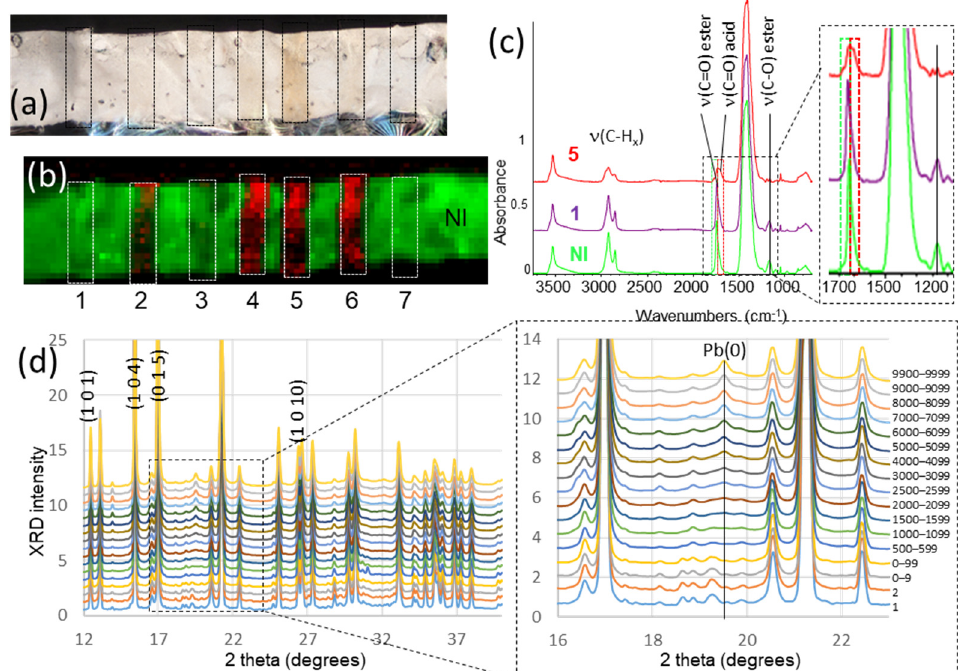
Figure 1. Assessment of radiation damage on a lead-white (mostly hydrocerussite) oil paint mock- up. Seven µXRPD maps were acquired at ID13, with the following conditions (1 or 3 repeats; differ- ent dwell times; at low flux (LF) or high flux (HF)): 1: 1 scan, 0.01 s, LF; 2: 1 scan, 0.01 s, HF; 3: 1 scan, 0.03 s, LF; 4: 1 scan, 0.03 s, HF; 5: 1 scan, 0.1 s, HF; 6: 3 scans, 0.01 s for each scan, HF; 7: 3 scans, 0.01 s for each scan, LF. The pixel size was 2.5 × 2.5 µm 2 to avoid overlap between two consecutive points. The map width was 50 µm and the height sufficient to cover the entire thickness of the paint sample. The maps are represented as rectangles in ( a , b ). ( a ) Optical microscopy after µXRPD. ( b ) µFTIR map acquired in transmission mode (beam size 15 × 15 µm 2 , pixel size 10 × 10 µm 2 , 50 cumulated scans per spectrum) after performing the µXRPD maps. The red/green display shows the integrated in- tensity over the ν (CO) acid range (1683–1724 cm − 1 ) and ν (CO) ester range (1726–1759 cm − 1 ), respec- tively. These regions are displayed in ( c ) by a red and green rectangle, respectively. ( c ) Average FTIR spectra calculated over map 1, map 5 and a non-irradiated (NI) region. ( d ) XRPD 1D patterns measured with repeated acquisitions of 10 ms at LF; from bottom to top: 1st scan, 2nd scan, average of the first 10 scans, of the first 100 scans, and then average from x to x + 99, for x = 500, 1500, 2000, 2500, 3000, 4000, 5000, 6000, 7000, 8000, 9000, and 9900. The peaks assigned with Miller index (h k l) values are those for which the evolution of the position and full-width-at-half-maximum (FWHM) is reported in Figure S4.